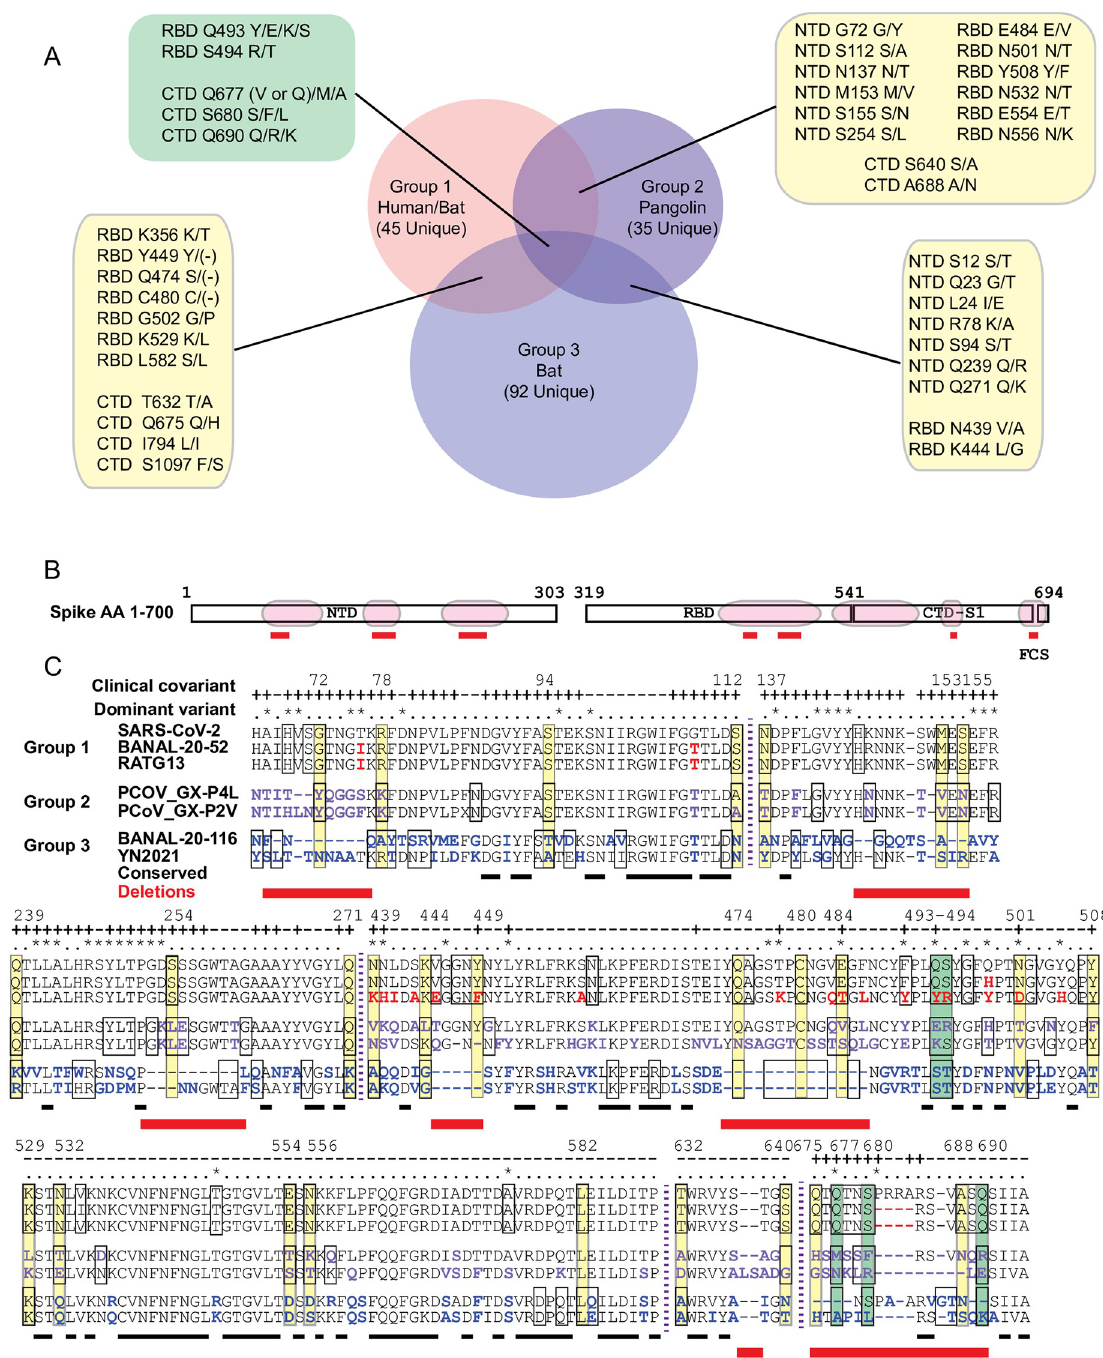
Fig 3. The distribution of spike covariant residues found in CoVs Groups 1–3. (A) The number of unique and shared covariant residues between Groups 1, 2, and 3. (B) Overview of covariant residue-enriched domains including NTD, RBD, and FCS that are shown in detail in (C). (C) Aligned AA sequences of covariant residue-enriched regions of spike with representatives from Group 1, Group 2, and Group 3. The residues identical to SARS-CoV-2 are colored black. Residues that differ from SARS-CoV-2 are colored within each of the three groups (red, purple, and blue). Boxed residues indicate those covariant within and between groups. Covariant sequences that are common to two groups are boxed in yellow and those to all three in green and listed in (A). Residues identified as clinical covariants are indicated (+). Residues present in dominant circulating variants are indicated ( � ). Conserved residues are underlined and residues deleted when these groups are compared marked with a red box underneath the